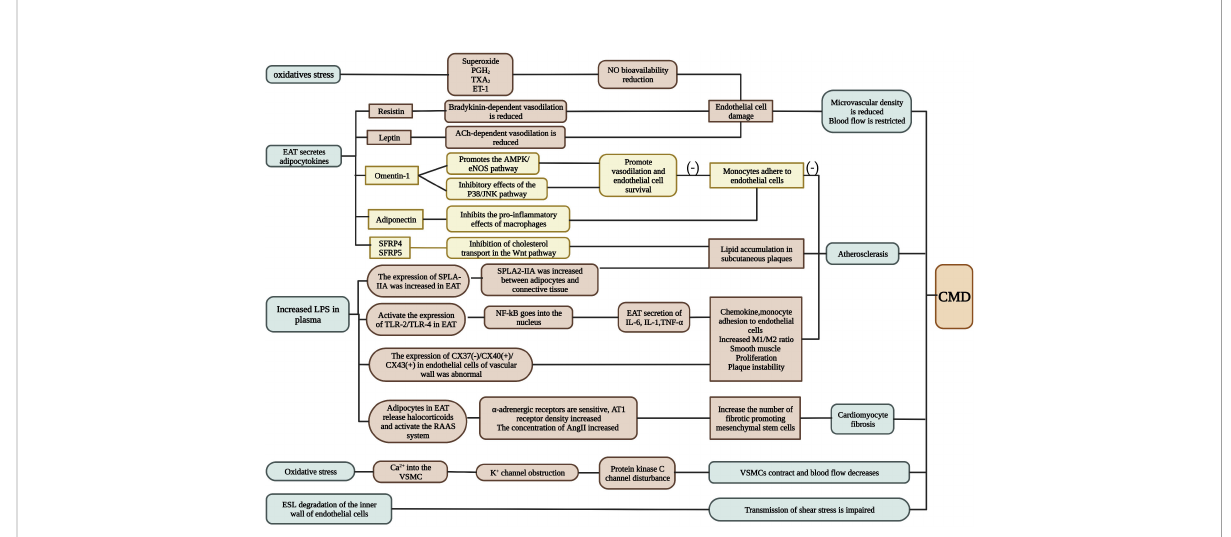
FIGURE 2 The mechanism of INOCA. INOCA is represented by CMD. It can be caused by oxidative stress, adipokines produced by EAT, changes in circulating factor concentrations in plasma, and changes in ESL. CMD is determined by a combination of factors including endothelial dysfunction, vascular smooth muscle cell hyperreactivity, vascular remodeling, vascular fi brosis, and changes in macrophage function (see text for details). A possible adjustment procedure is proposed for this. CMD: coronary microvascular dysfunction.*Green represents several conditions that produce CMD under abnormal EAT; brown represents pathways that promote in fl ammation; yellow represents pathways that inhibit in fl ammation. (Created with